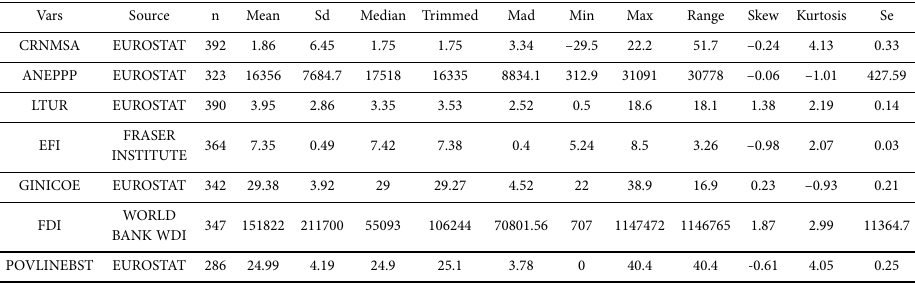
Table 1. Variables characteristics